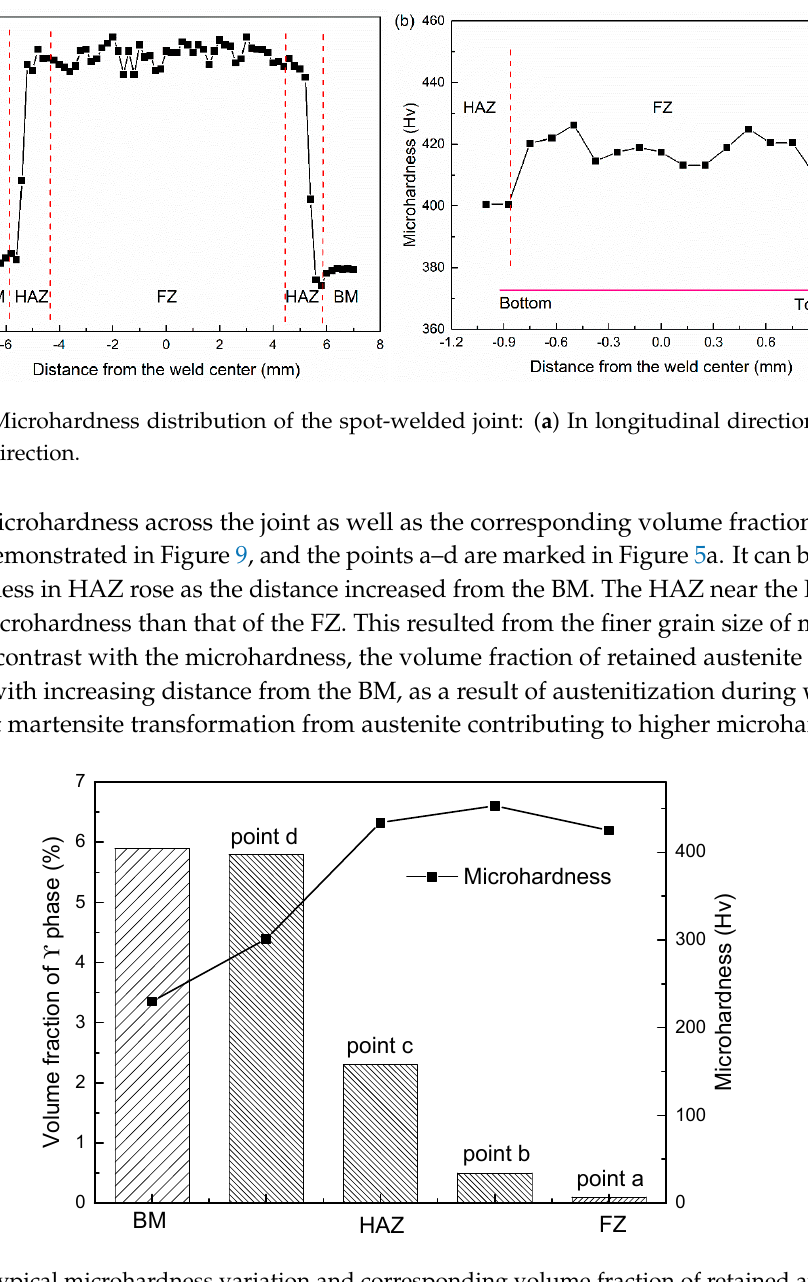
Figure 9. Typical microhardness variation and corresponding volume fraction of retained austenite ( γ phase).